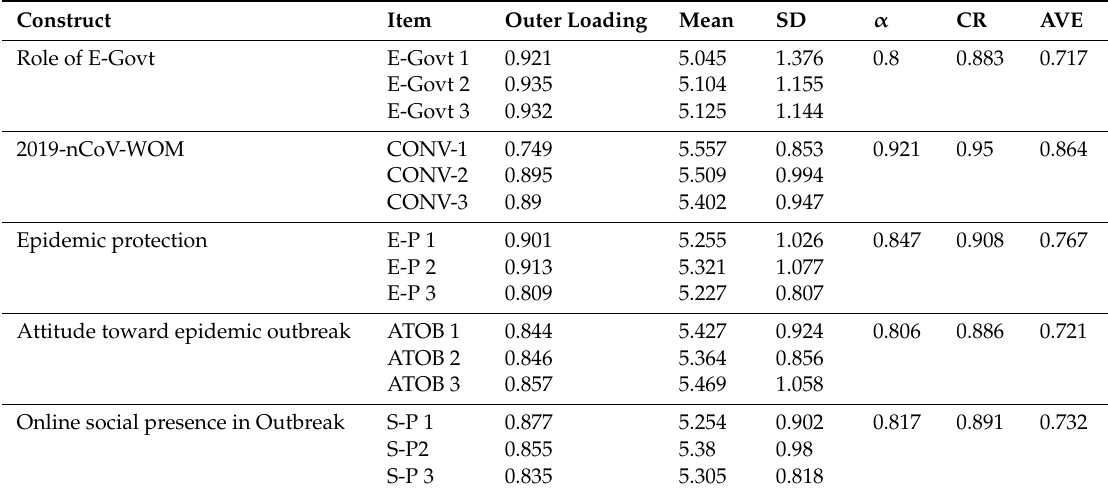
Table 3. Reliability and validity of measurement scales.